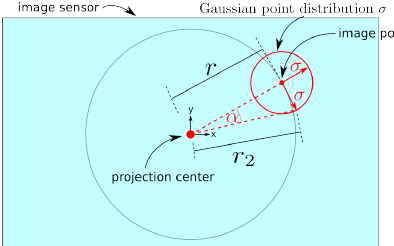
Figure 1: Image distribution; Illustrated Gaussian image distri- bution (exaggerated). As it is circular, the axes can be chosen ar- bitrarily, here perpendicular and tangential to the circle. Note that for the radial axis, only the radius and hence, the angle θ changes. For the tangential axis, the radius r increases to r 2 (again: also θ ) as well as the angle α on the